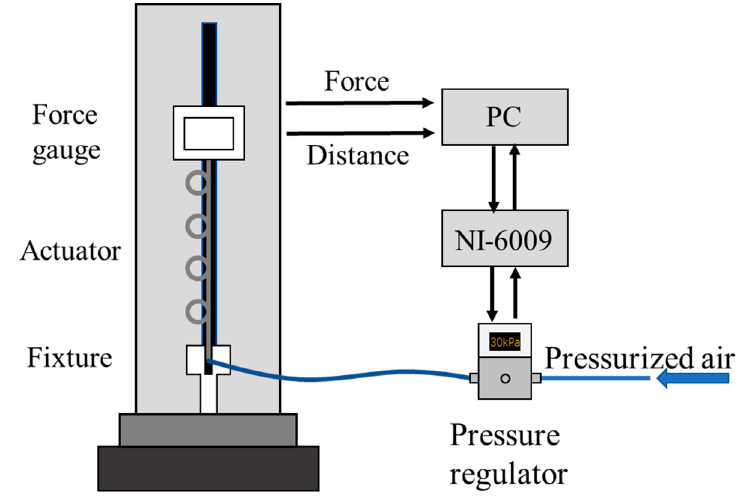
Figure 6. Test bench to acquire output characteristics.